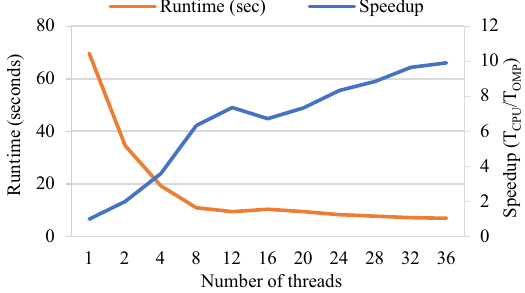
Fig. 9. Runtime and speedup for the parallel implementation on multicore CPU using OpenMP